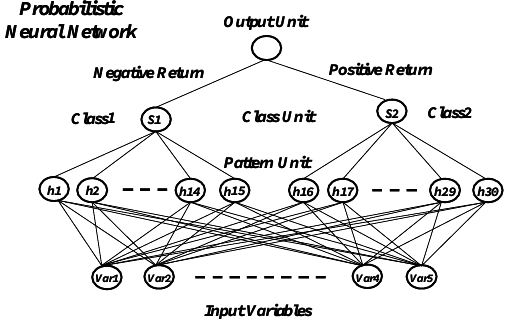
Fig. 7 The architecture of the designed